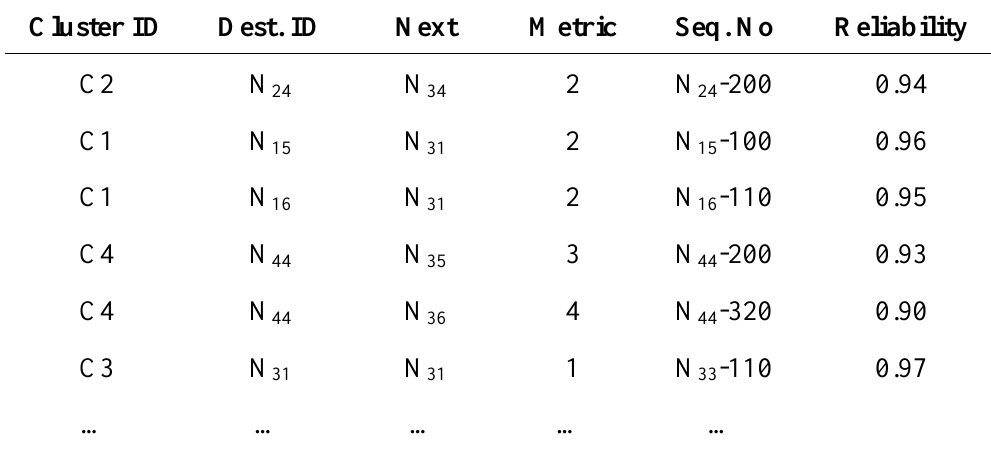
Table 1. N33’s routing